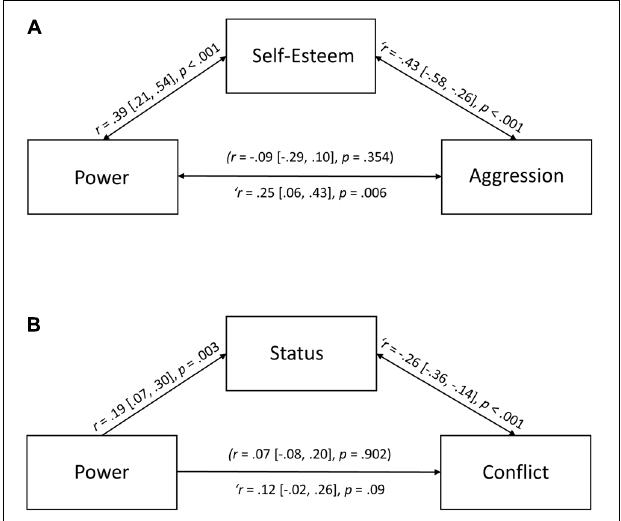
FIGURE 2 | Perceived worth ( A : self-esteem; B : status) buffering the influence of power on aggression and